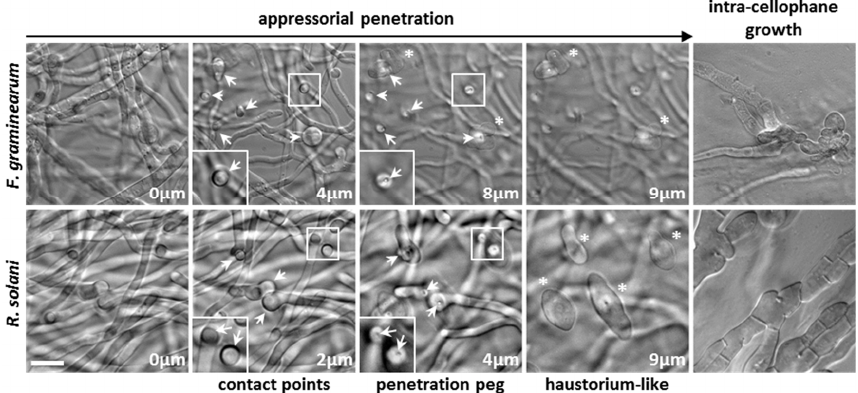
Figure 1. Fusarium graminearum and Rhizoctonia solani penetrate cellophane through appressoria. For both F . graminearum ( upper panel) and R . solani ( bottom panel), the main steps of appressorium-based cellophane penetration have been represented. From left to right, the four first columns represent successive z-planes of the same field of view. The distances from the initial z-plane are indicated. Arrows indicate contact points and the penetration peg they emit to penetrate cellophane. (*) Haustorium-like growth. Last column ( right ) shows in-depth intra-cellophane mycelial development. Scale bar = 10 µm. Magnification in the bottom insets is 1.7×.